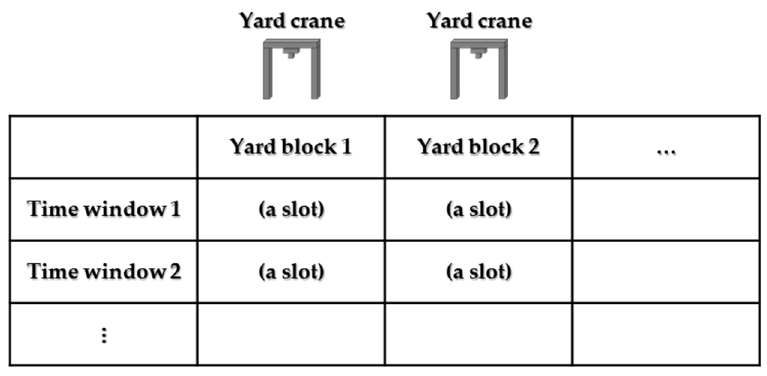
Figure 3. The Truck Appointment System (TAS) expressed in a discrete form.